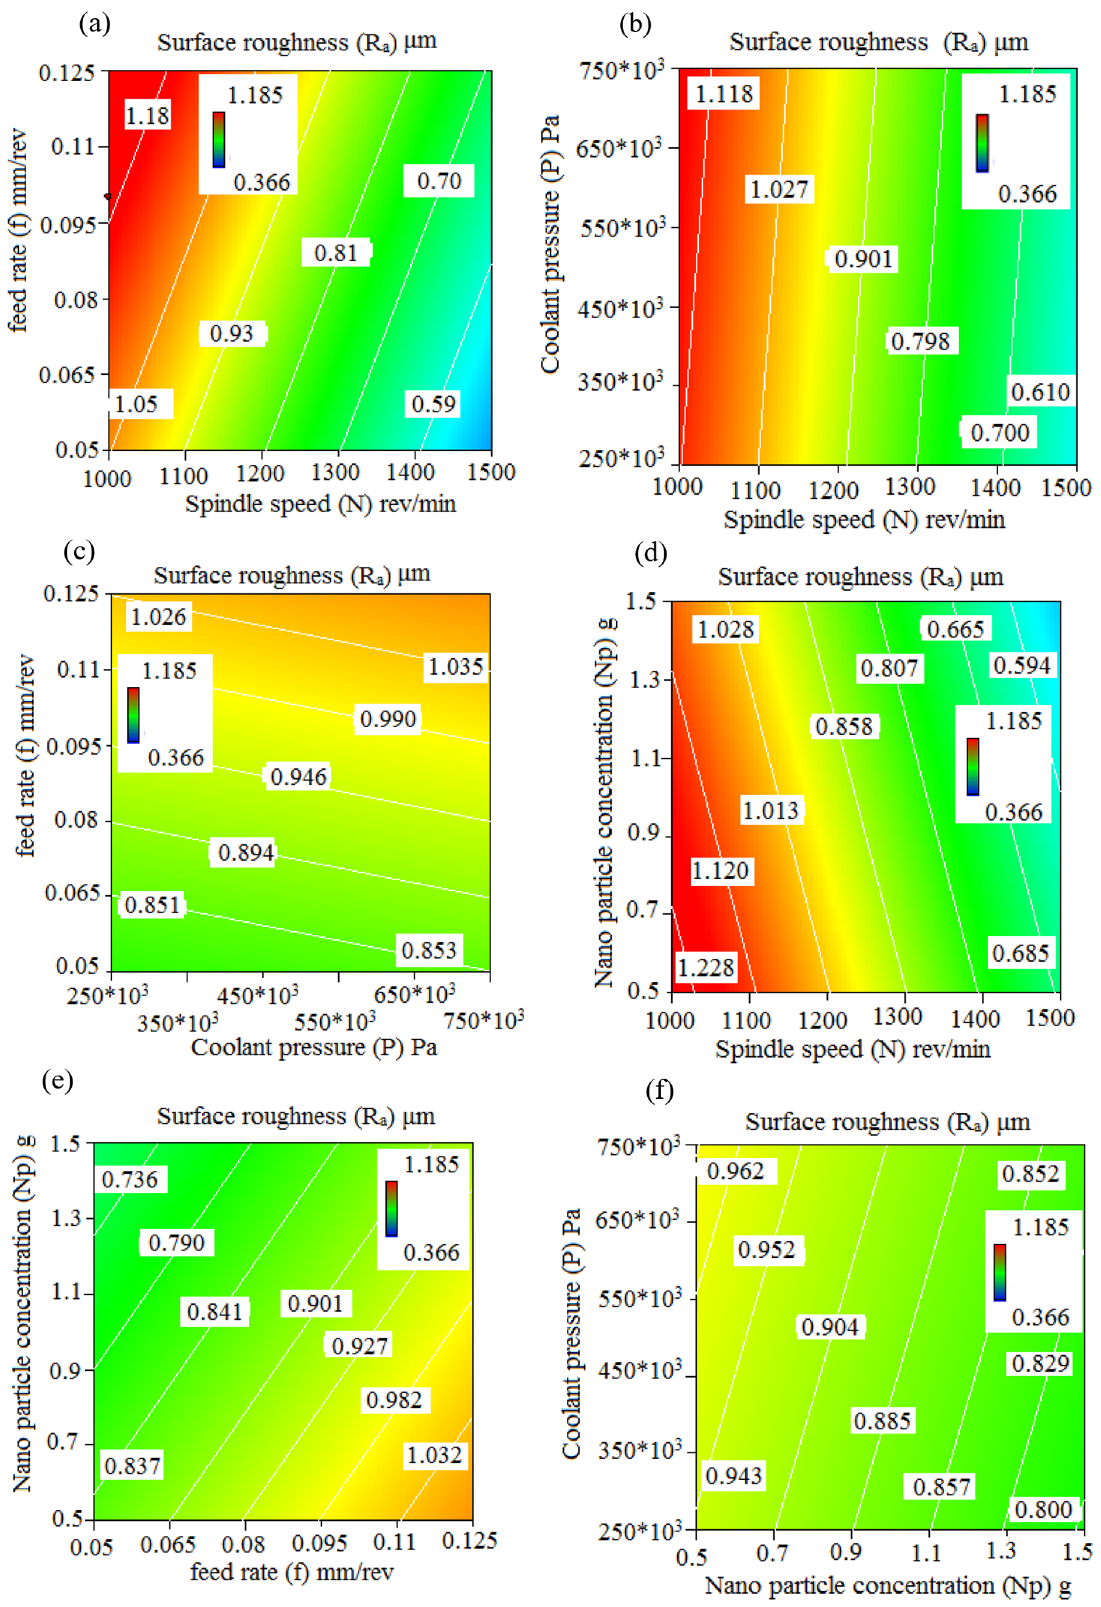
Fig. 8. (a-f) Effect of Process Parameters on ‘ R a ’ (a) Effect of ‘ N ’ at different level of ‘ f ’ on ‘ R a ’ (b) Effect of ‘ N ’ at different level of ‘ P ’ on ‘ R a ’ (c) Effect of ‘ f ’ at different level of ‘ P ’ on ‘ R a ’ (d) Effect of ‘ N ’ at different level of ‘ N p ’ on ‘ R a ’ (e) Effect of ‘ f ’ at different level of ‘ N ’ on ‘ R ’ (f) effect of ‘ P ’ at different level of ‘ N p a